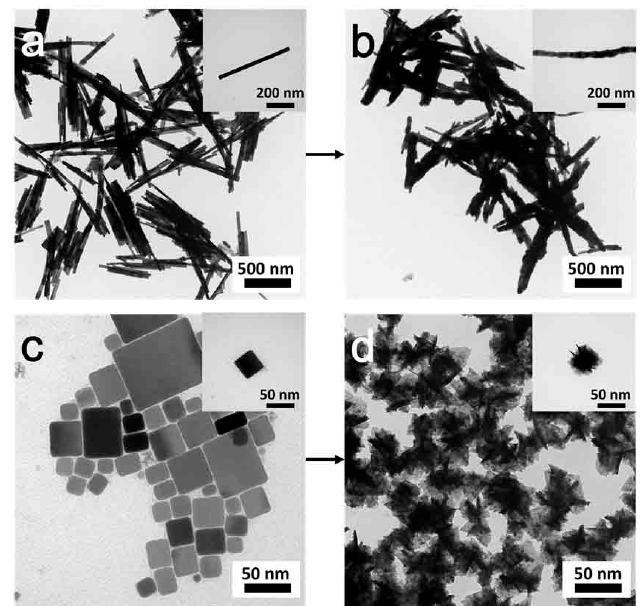
Figure 9. TEM of converting ( a ) CuTe nanorods into ( b ) CuInTe 2 nanorods, and converting ( c ) CuTe nanocubes into ( d ) CuInTe 2 nanocrystals.